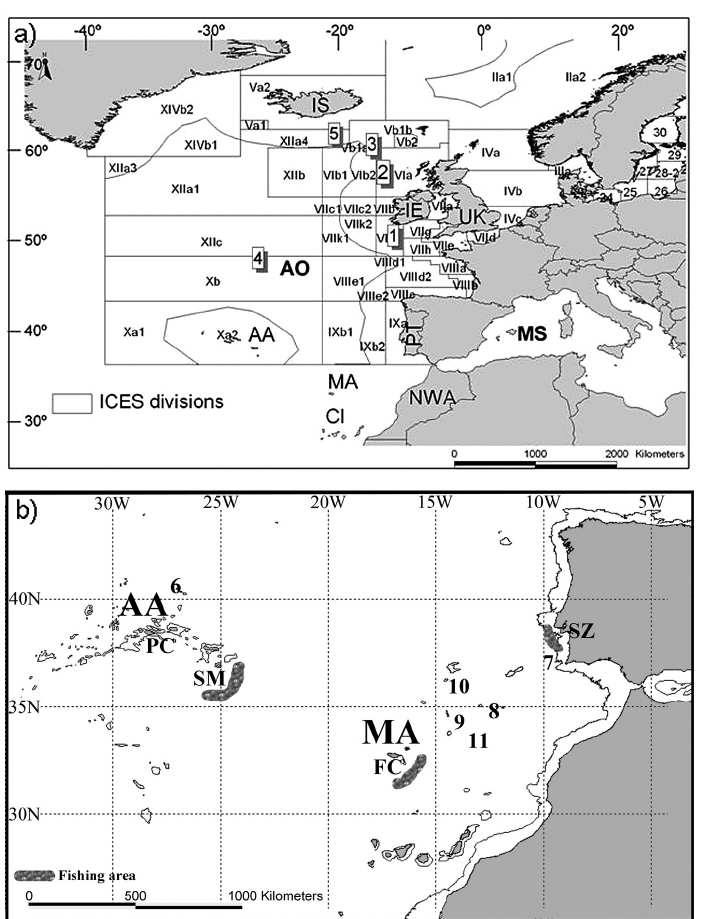
Fig . 1. – a) Map of the northeast atlantic with the ICeS divisions and b) the southern northeast atlantic with the sampling locations of black scabbardfish and the 1000 m isobath. aa, azores archipelago; ao, atlantic ocean; CI, Canary Islands; FC, Funchal; Ie, Ireland; IS, Iceland, Ma, Madeira archipelago; MS, Mediterranean Sea; nWa, northwest africa; PC, Pico Island; PT, mainland Portugal; SM, Santa Maria Island; SZ, Sesimbra (mainland Portugal); UK, United Kingdom; 1, Porcupine Seabight; 2, rockall Trough; 3, Hatton Bank; 4, Faraday seamount; 5, reykjanes ridge; 6, Sedlo seamount; 7, Gorringe seamount; 8, ampère seamount; 9, Unicorn bank; 10, Lion seamount; 11, Seine